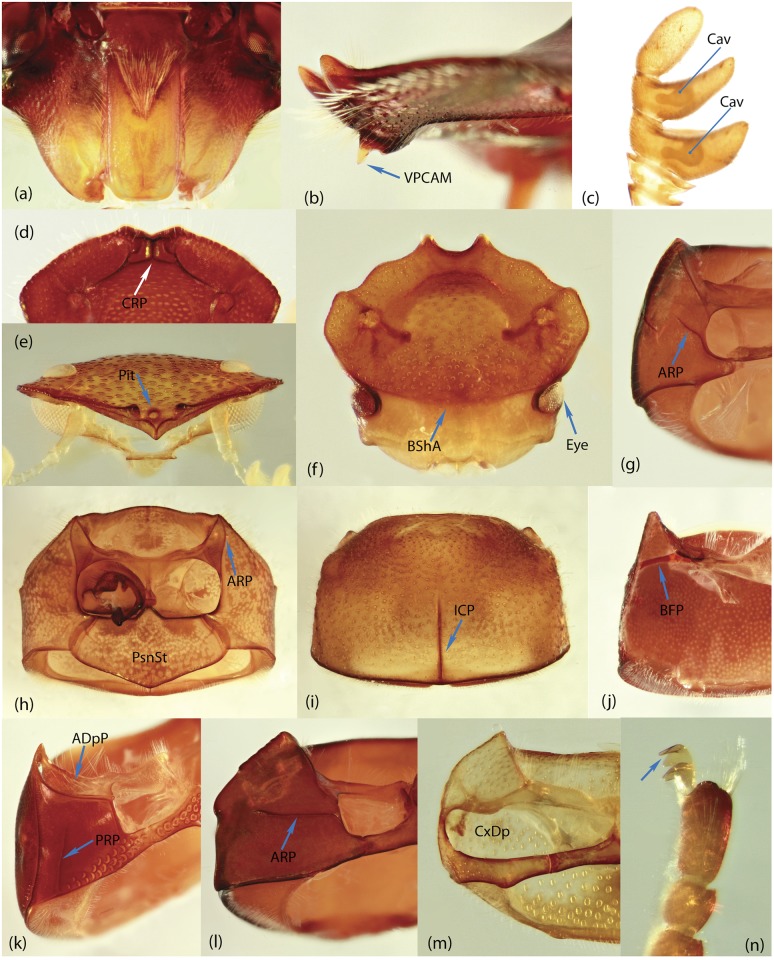
Morphological structures of Scarabaeinae.a, Aulacopris maximus; b, Dichotomius sericeus; c, Onthophagus seniculus; d, Aphengium sordidum Harold, 1868; e, Zonocopris gibbicollis; f, Cryptocanthon paradoxus; g, Anomiopus edmondsi; h, Eurysternus hamaticollis; i, Neosisyphus sp.; j, Sarophorus costatus; k, Coptodactyla nitida; l, Hansreia sp.; m, Epactoides sp1.; n, Pseudonthobium sinuatotibiale; a, head ventral view; b, head left lateral view; c, antennal club; d, clypeus ventral view; e, head frontal view; f, head dorsal view; g, h, k, l, m, prothorax, ventral view; i, prothorax, dorsal view; j, prothorax, ventral view, propleurae and prosternum removed; n, fore tarsi, bifurcation of claws arrowed.